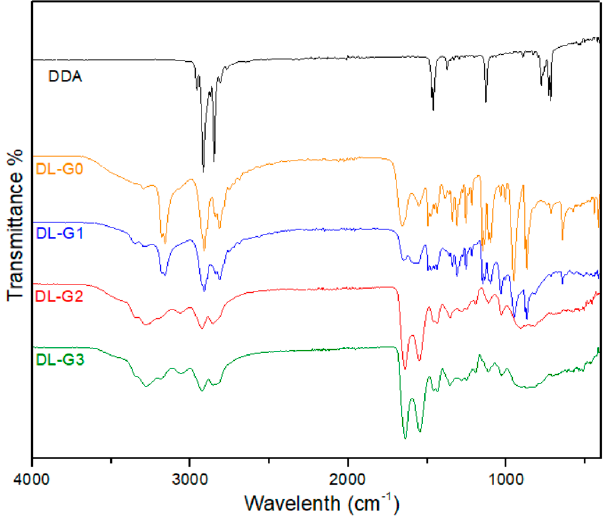
Figure 1. FT-IR analysis of PAMAM dendron-bearing lipids.